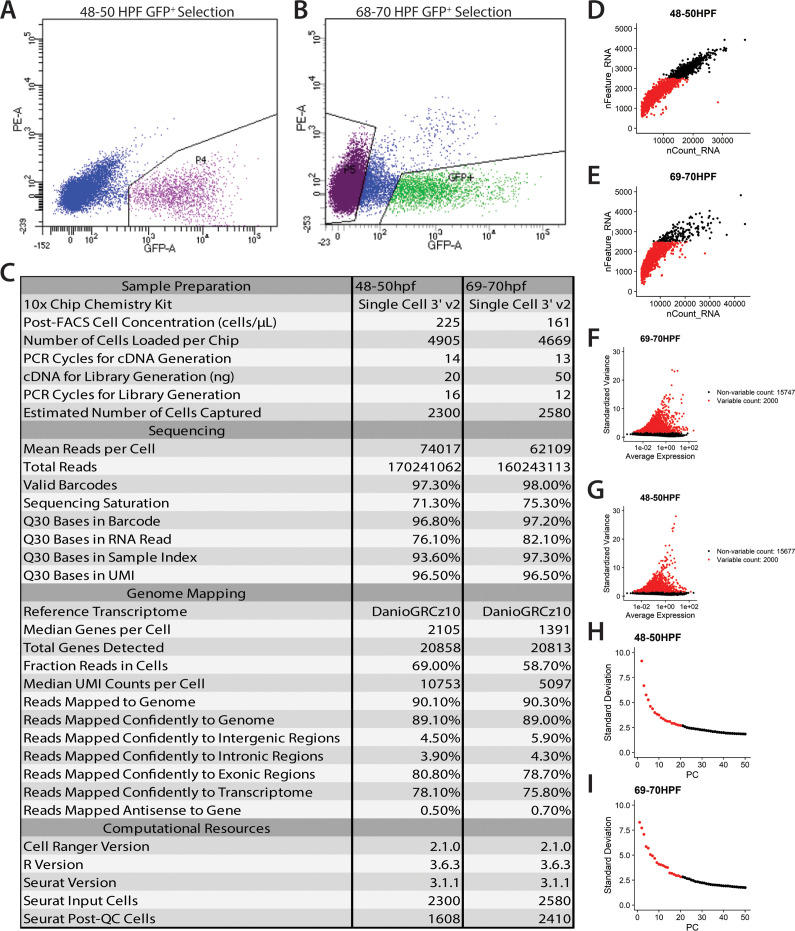
Statistics on generation and filtering of single cell transcriptomes at 48–50 hpf and 68–70 hpf.(A,B) Fluorescence activated cell sorting plots highlighting the GFP+ cell population sorted at 48–50 hpf (A) and 68–70 hpf (B). (C) Table of general statistics pertaining to the sequencing and alignment of reads from the Cell Ranger pipeline. Additional metrics provided were derived from the Seurat R package as described in the Materials and Methods section. (D,E) Plots showing the feature selection for both the 48–50 hpf (D) and 68–70 hpf (E) datasets. Cells were selected such that they had fewer than 2500 features to reduce spuriously sorted cells. (F,G) Top 2000 most variably expressed genes were identified and used for further downstream identification of significant principal components, as described in the Materials and Methods section. (H,I) Most significant principal components (top 20 for both datasets) were selected to be used for subsequent cluster identification and cell embedding in tSNE and UMAP spaces.